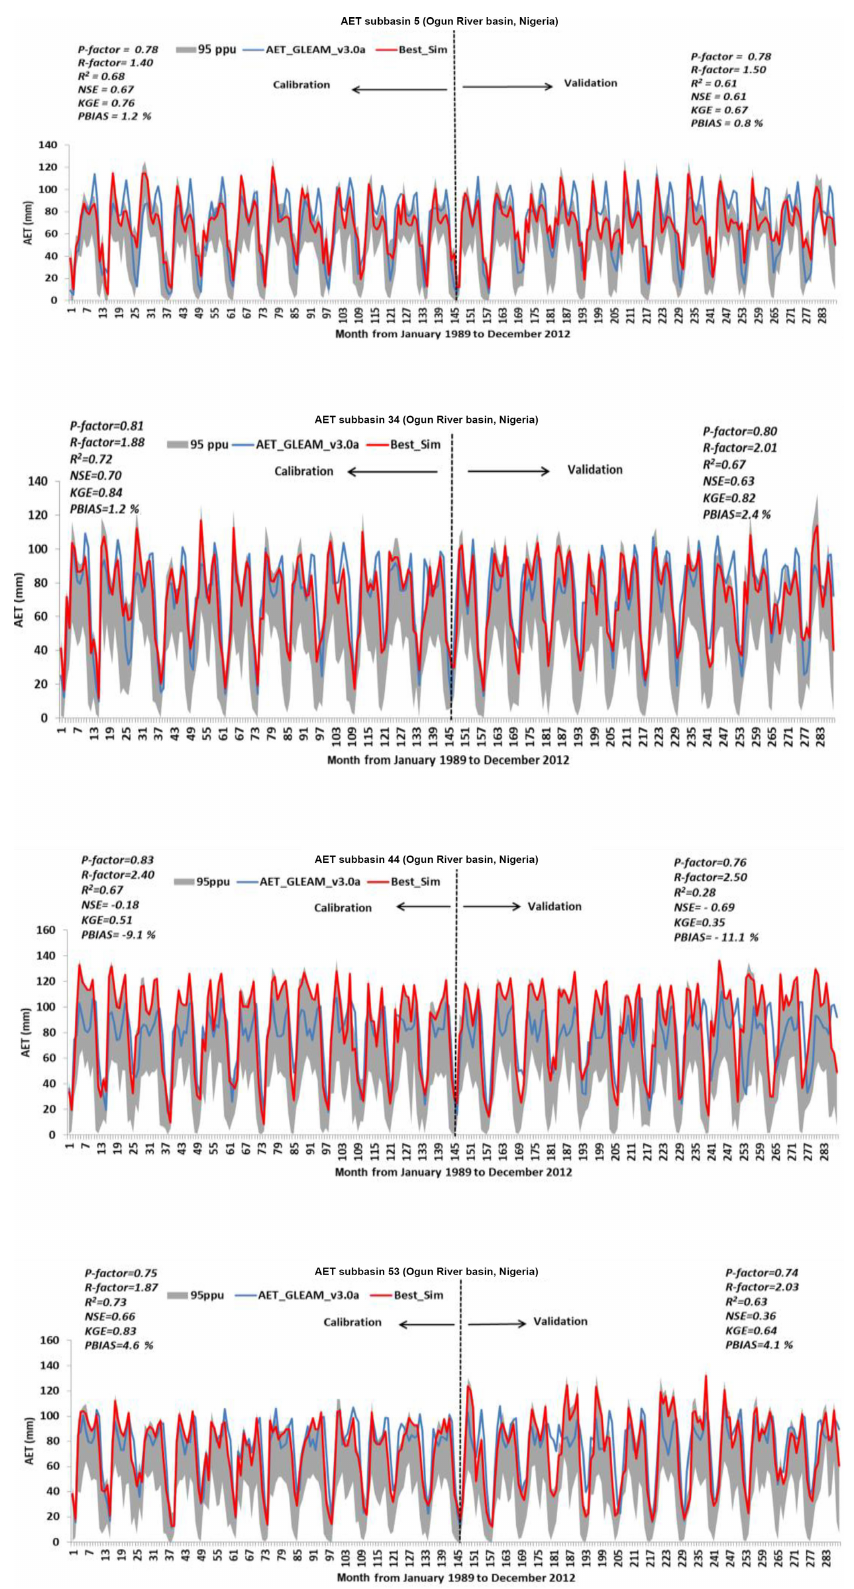
Figure 10. Extracts of the monthly calibration and validation results (GSI) showing the 95% prediction uncertainty interval along with the best SWAT-simulated actual evapotranspiration and satellite-based actual evapotranspiration (GLEAM-v3.0a). Hydrol. Earth Syst. Sci., 23, 1113–1144, 2019